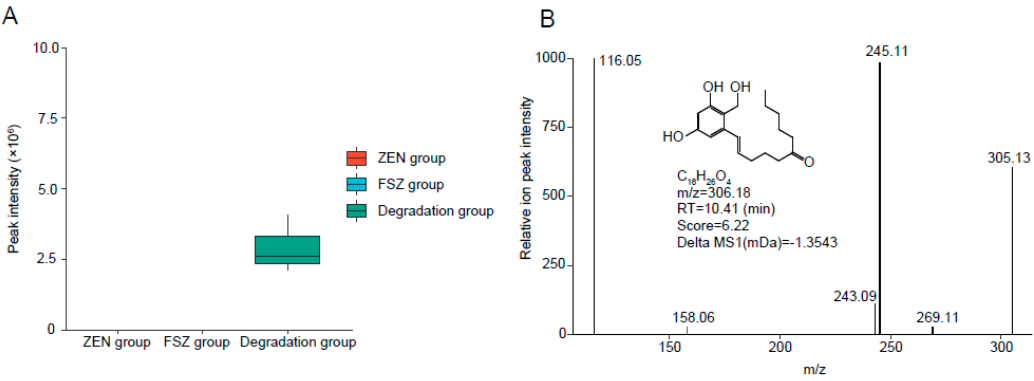
Figure 6. Exploration of ZEN degradation products: ( A ) analysis of the content change of the degradation product FSZ − P; ( B ) structural information analysis of the degradation product FSZ − P.